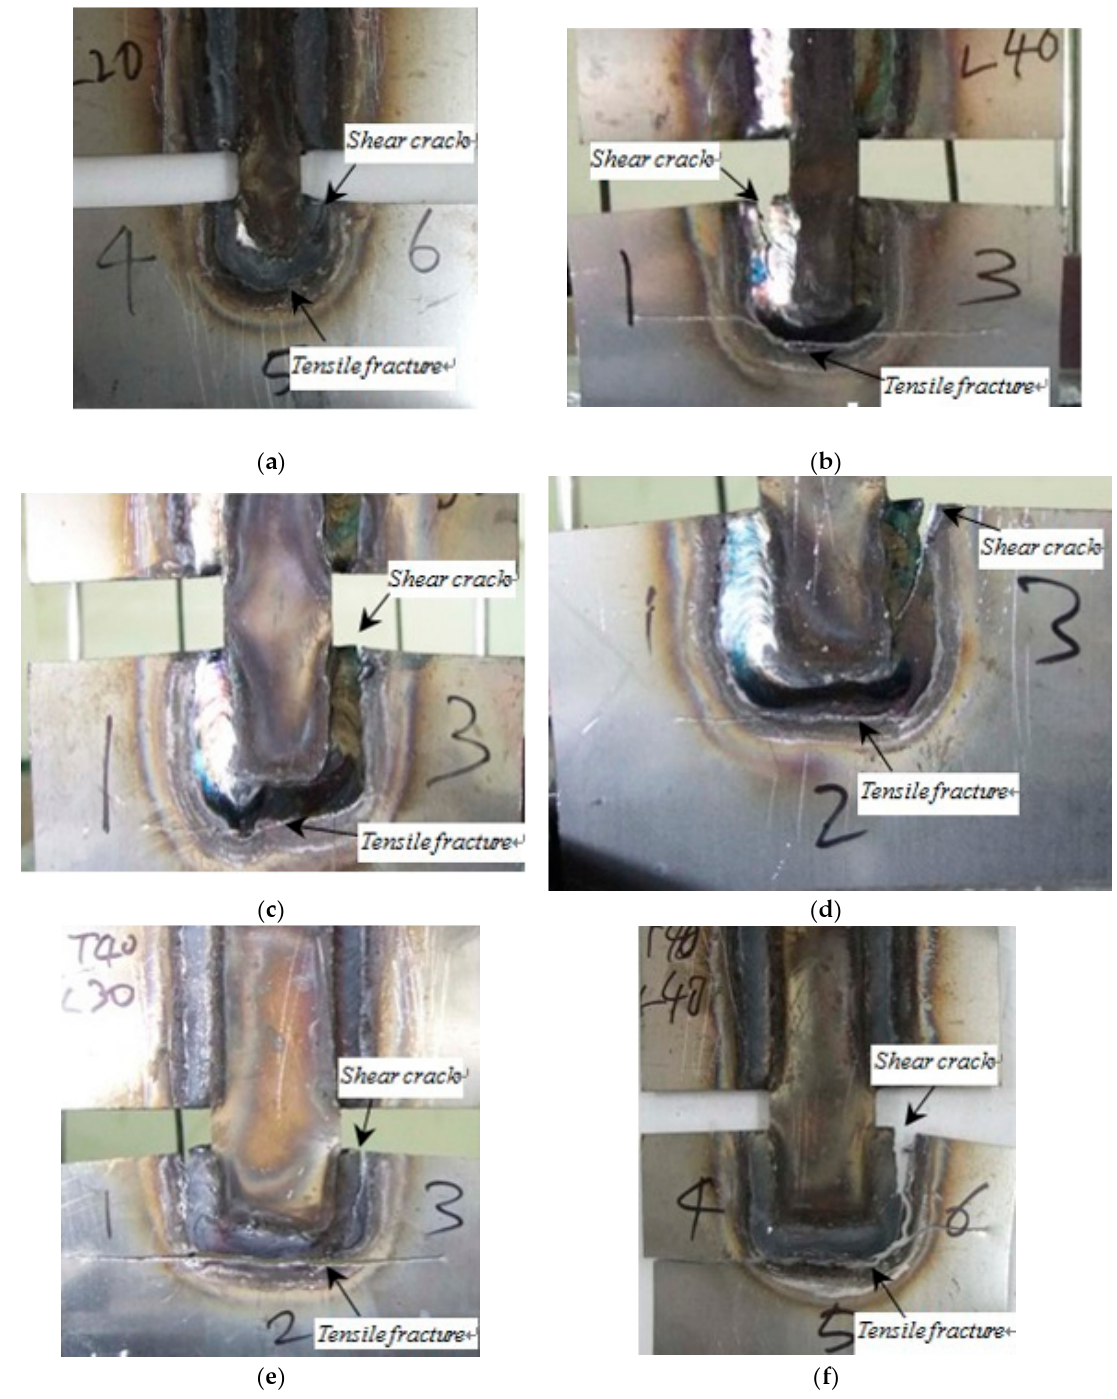
Figure 1. Fracture shapes of specimens at test end: ( a ) FT20L20, ( b ) FT20L40, ( c ) FT30L40, ( d ) FT30L40, ( e ) FT40L30, ( f ) FT40L40.